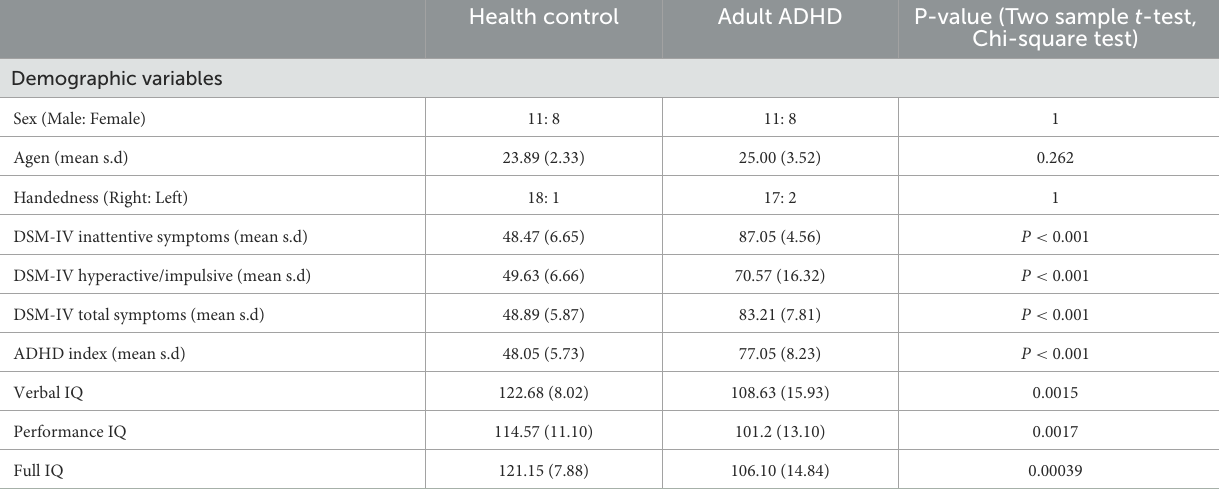
TABLE 1 Demographics of participants.